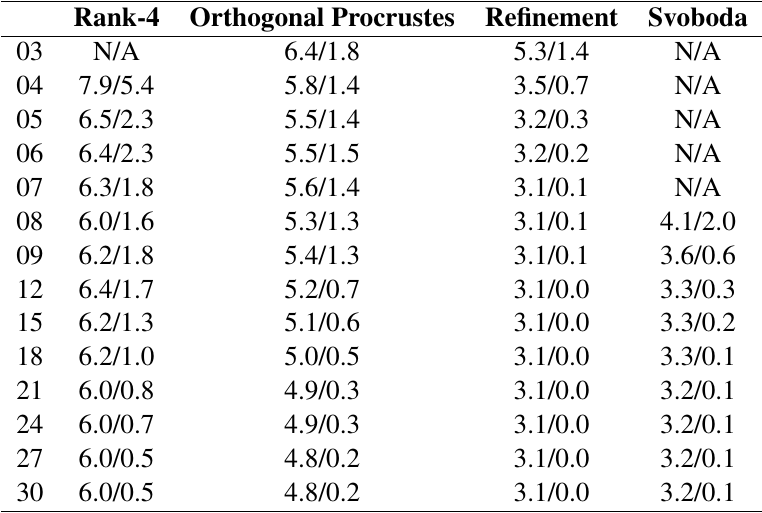
Table 2. Projection error (pixel). The first column represent the number of training